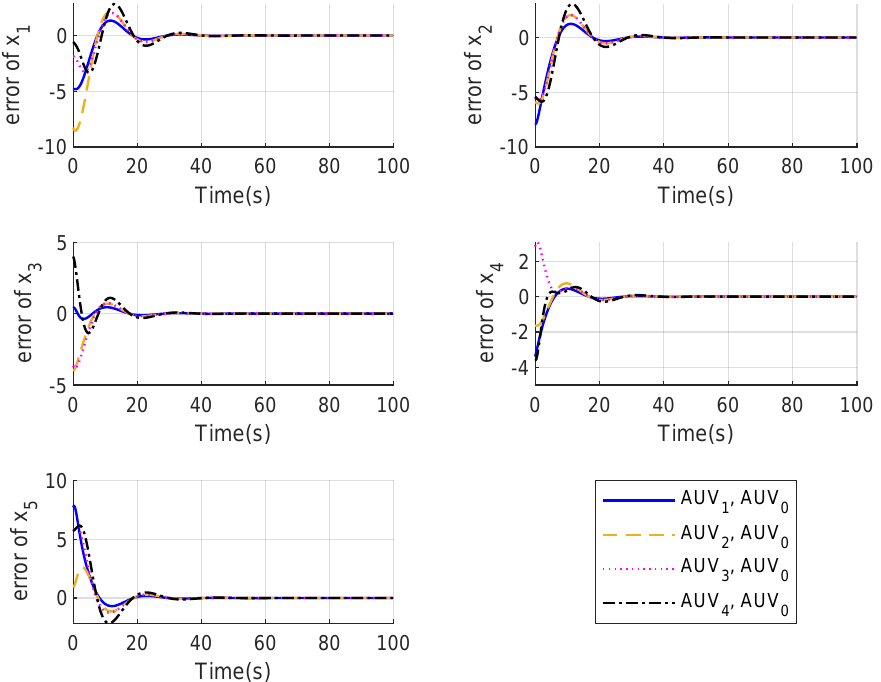
Figure 9. Errors of position state under alterable communication topology without delay.